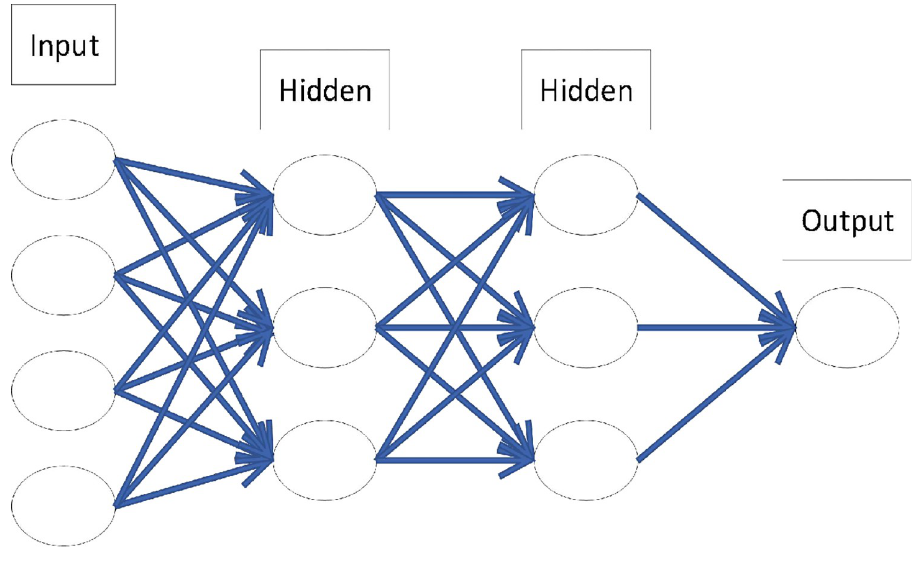
Fig 2. The LSTM network